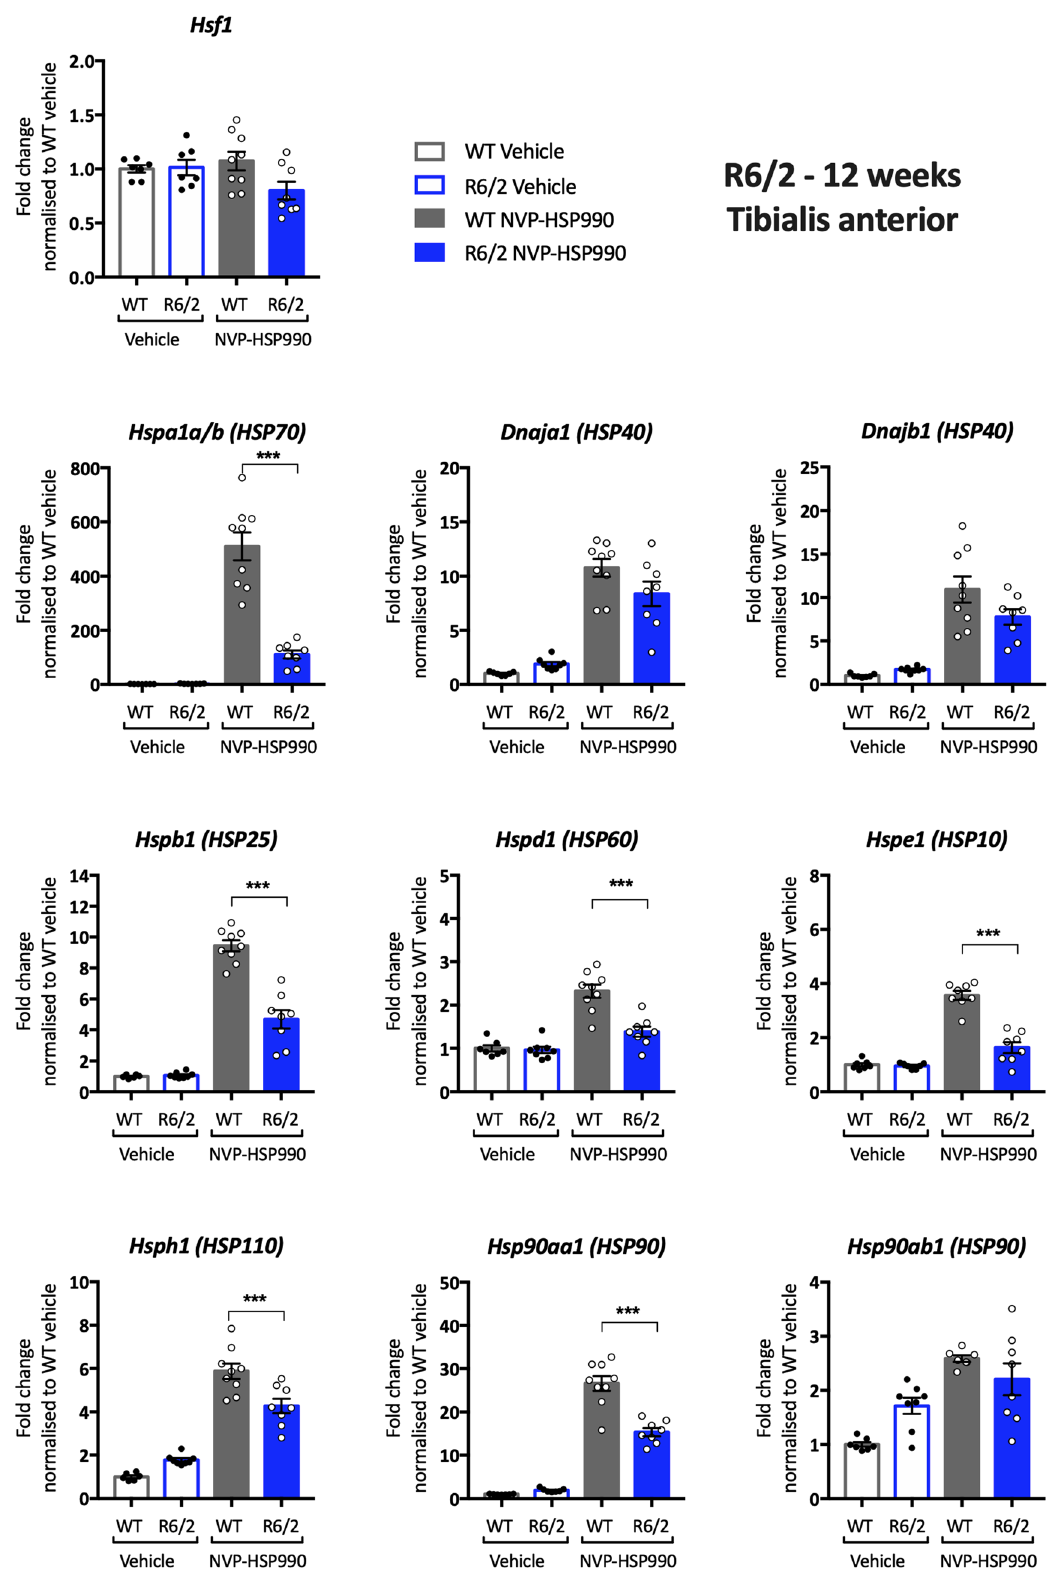
Figure 7. Analysis of the heat shock response in the tibialis anterior of R6/2 mice at 12 weeks of age. The expression of heat shock genes was measured using the QuantiGene 16-plex assay in the tibialis anterior of wild-type and R6/2 mice at 11–12 weeks of age that had been treated with vehicle or NVP-HSP990. The NVP-HSP990 treated samples were normalised to the corresponding wild-type vehicle treated samples. N = 6–9/genotype/treatment. Statistical analysis was by two-way ANOVA with Bonferroni correction for multiple comparisons. Mean ± SEM. *** p ≤ 0.001. Test statistical values can be found in Supplementary Table S14 online. WT